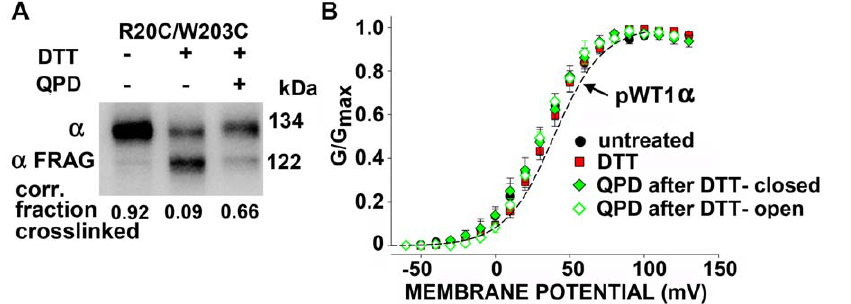
Figure 5. Disulfide bond formation between R20C flanking S0 and W203C in S4. (A) Intact cells transfected with BK a R20C/W203C were treated and analyzed as in Fig. 4. The extents of crosslinking, corrected for the efficiencies of HRV-3C cleavage, are shown below the blots. N=2. (B) Normalized G-V curves of R20C/W203C either untreated (black), after 10 mM DTT for 5 min (red), after DTT and 40 m M QPD for 2 min, applied in the closed state (filled green diamond), or after DTT and QPD applied in the open state (open green diamond). Fits of a Boltzmann equation were to the means and SD of normalized conductances from separate patches. The dashed line indicates the G-V curve of pWT1 a channels. The pipette solution contained 10 m M Ca 2 + . N=3–6.